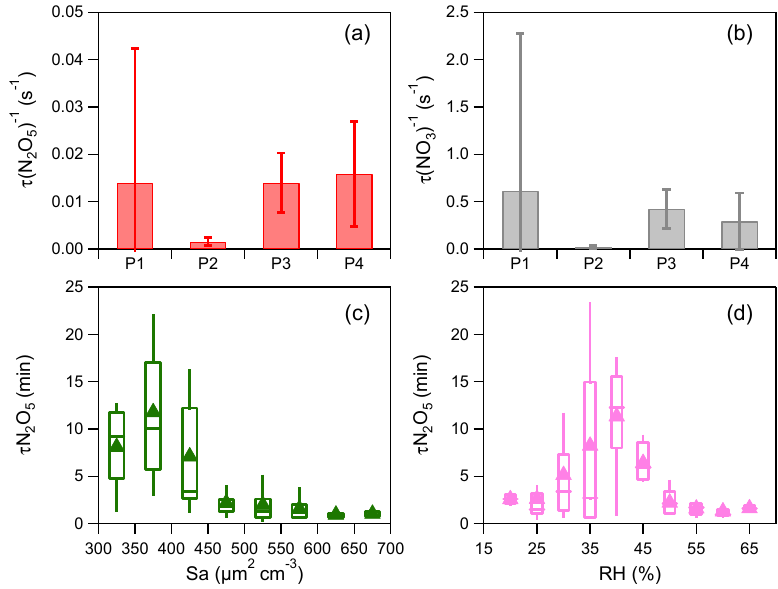
Figure 3. (a–b) Average reactivity of N 2 O 5 ( τ (N 2 O 5 ) − 1 ) and NO 3 ( τ (NO 3 ) − 1 ) for different nights (i.e., P1, P2, P3, and P4). The error bar represents the standard deviation. (c) Variations of the nocturnal τ (N 2 O 5 ) as a function of aerosol surface area density ( S a ) and (d) variations of the nocturnal τ (N 2 O 5 ) as a function of relative humidity (RH). The data were binned according to S a (50µm 2 cm − 3 increment) or RH (5% increment). Mean (triangle), median (horizontal line), 25 and 75th percentiles (lower and upper box), and 10 and 90th percentiles (lower and upper whiskers) are shown for each